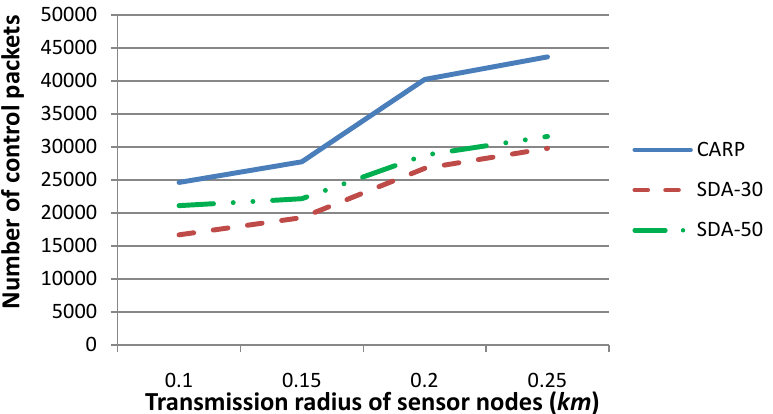
Figure 11. Comparison of the number of control packets for our technique (SDA) with respect to CARPas the routing protocol, when the transmission radius r is set to various values, and the number of sensor nodes, which drift with the water dynamics and change their coordinates, is set to various values. This figure shows that the number of control packets generated by our technique is much smaller than that of CARP, especially when the network topology is relatively